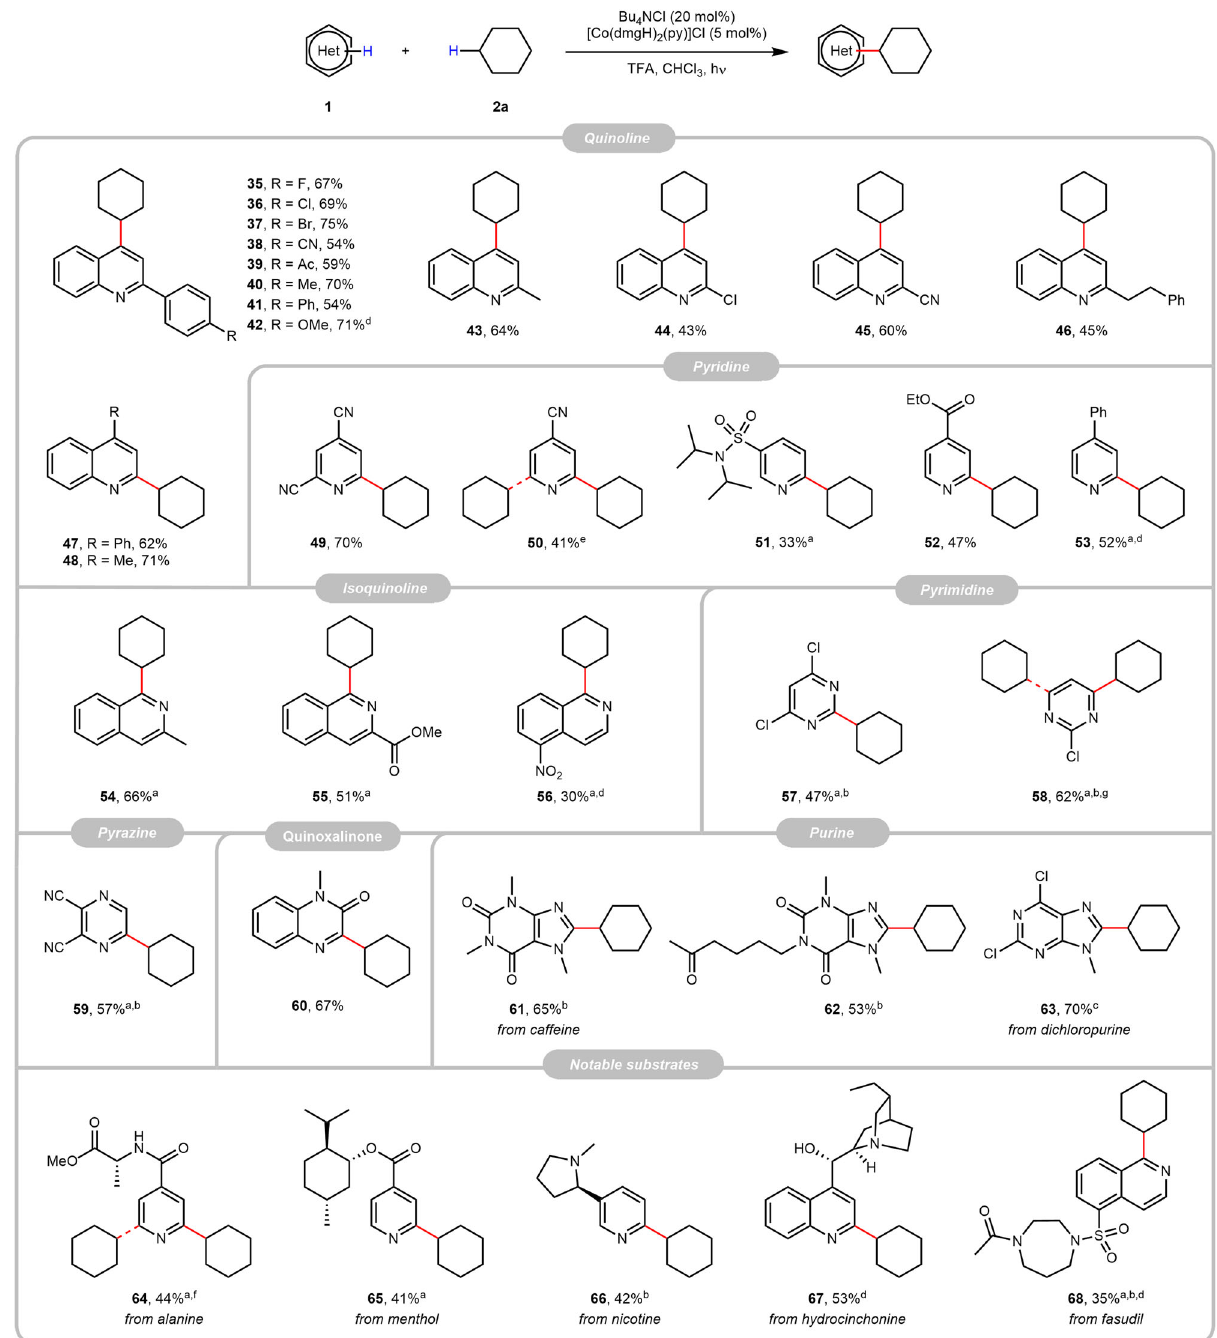
Fig. 3 Substrate scope of heteroarenes. Reaction conditions: 1 (0.2 mmol), 2a (0.6 mL), Bu 4 NCl (0.04 mmol), [Co(dmgH) 2 (py)]Cl (0.01 mmol), and TFA (0.6 mmol) in CHCl 3 (1.5 mL) under light irradiated at 20 – 25 °C for 20 h under N 2 , unless otherwise speci fi ed, and the yields were isolated ones. a The reaction was run for 36 h. b 4 equiv. of TFA was used. c 5 equiv. of TFA was used. d The reaction was heated to 55 – 60 °C. e Separable mixture, mono:di = 1.4:1. f Separable mixture, mono:di = 3.9:1. g Separable mixture, mono:di = 5.7:1; dmg dimethylglyoxime, TFA tri fl uoroacetic